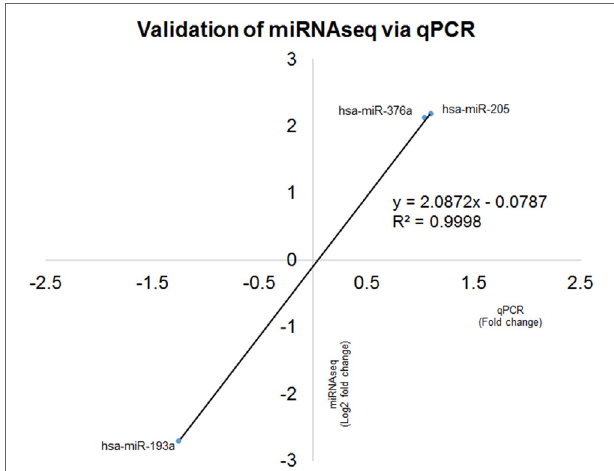
FigUre 8 | Correlation coefficient analyses for comparison between microRNA (miRNA) sequencing (miRNAseq) and qPCR validation of hsa-miR-193a-3p/5p, hsa-miR-376a-3p/5p and hsa-miR-205-3p/5p. The two technologies produced concordance result with R 2 = 0.9998, indicating the positive correlation of fold change of six selected miRNAs qPCR and